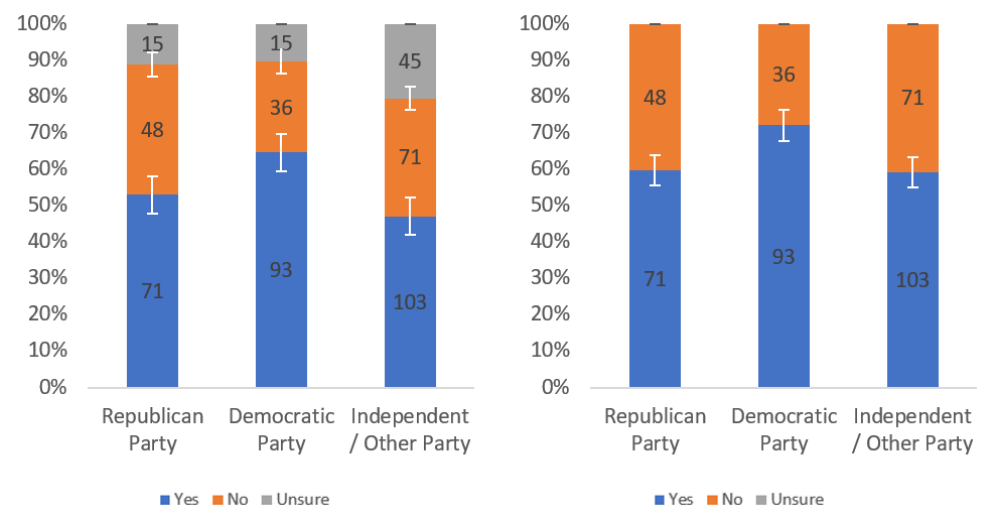
Figure 52. Responses regarding usefulness in judging trustworthiness by party affiliation including ( left ) and excluding ( right ) unsure responses.